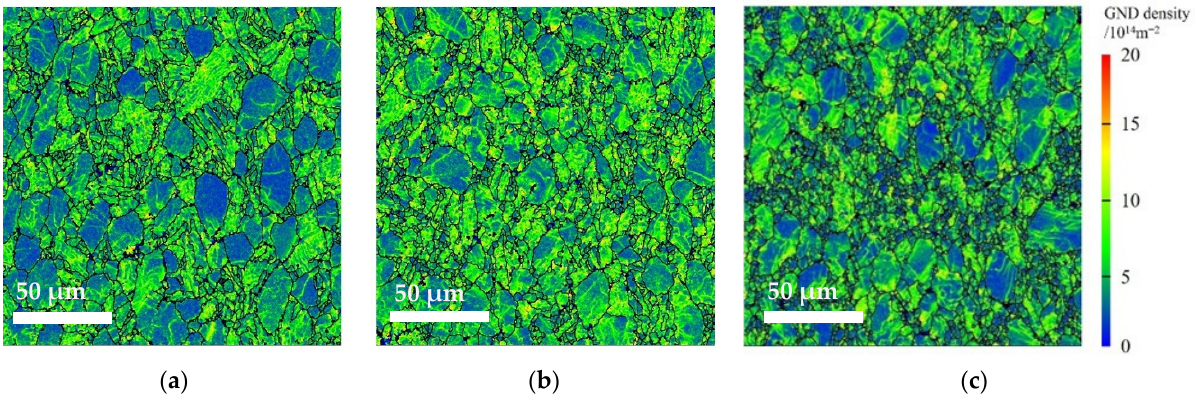
Figure 6. GND density maps of specimens without pre ‐ deformation: ( a ) 0.3; ( b ) 0.5; and ( c ) 0.7.